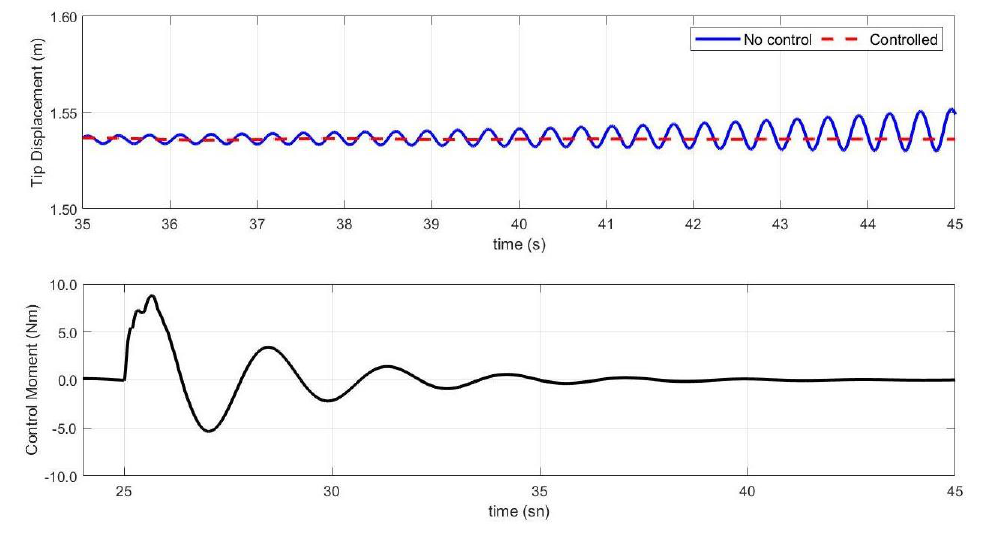
Figure 13. Tip response of the wing for controlled and uncontrolled cases and the resulting con- trol